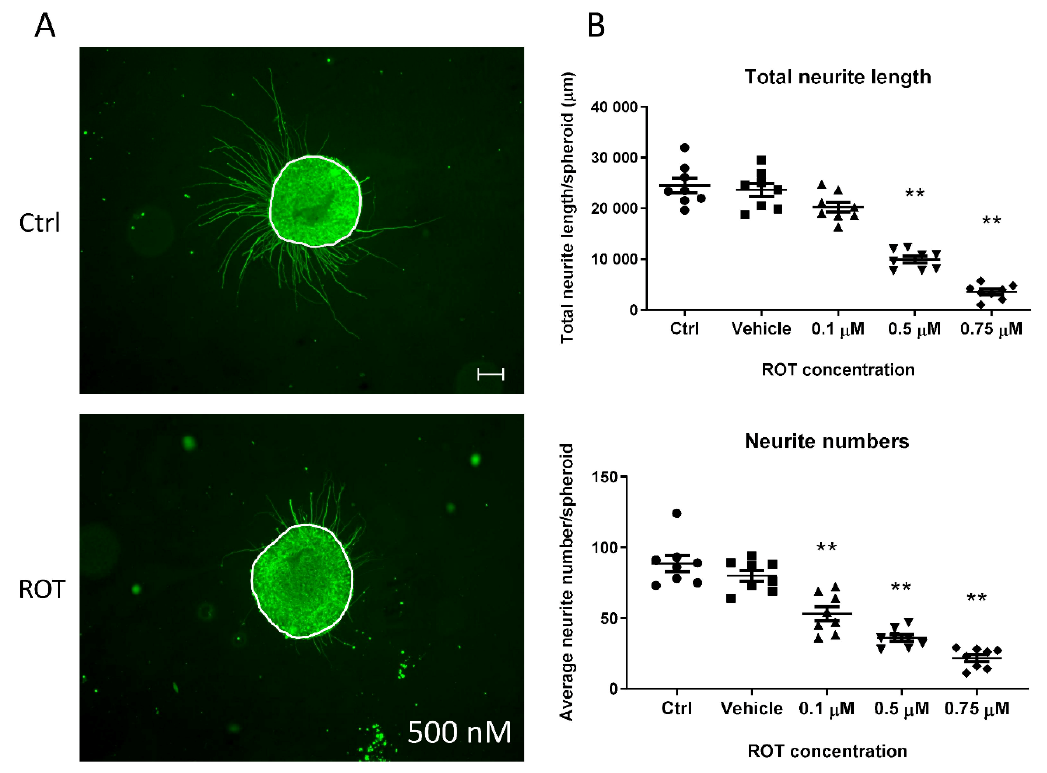
Figure 10. Neurite outgrowth measurement on D21 3D spheroids, exposed for 72 h with ROT. ( A ) Representative photograph of control (untreated) and ROT (0.5 µM) treated D21 spheroid immunolabeled with TUBB3 (in green). White lines represent the border of the spheroids where the neurite outgrowth was determined from, using ImageJ software (scale bar: 100 µm). ( B ) Total neurite length/spheroid (presented in µm ± SEM) and the average number of neurites/spheroids were determined 24 h after plating the treated spheroids. Different symbols denote treatment groups. ( n = 3, in each experiment 8 spheroids were treated in each group) (** p < 0.01).